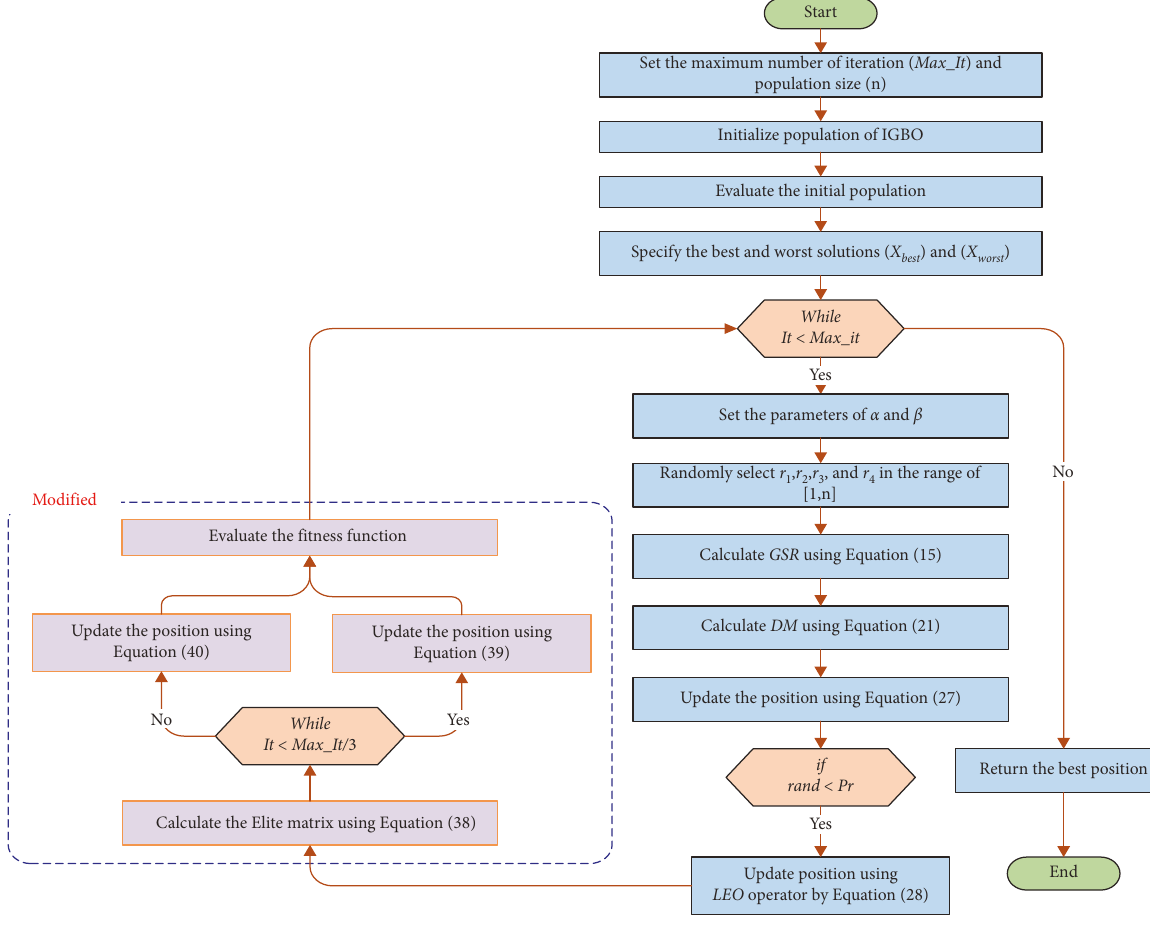
Figure 2: Flowchart of the proposed IGBO